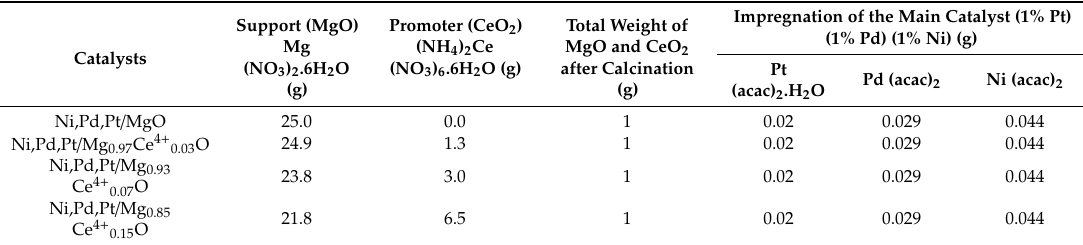
Table 5. Catalysts preparation with 0.1 M solutions of the mixed promoter and support followed by determining the total MgO weight with the promoter after precipitation with 1 M K 2 CO 3 and calcination at 1150 ◦